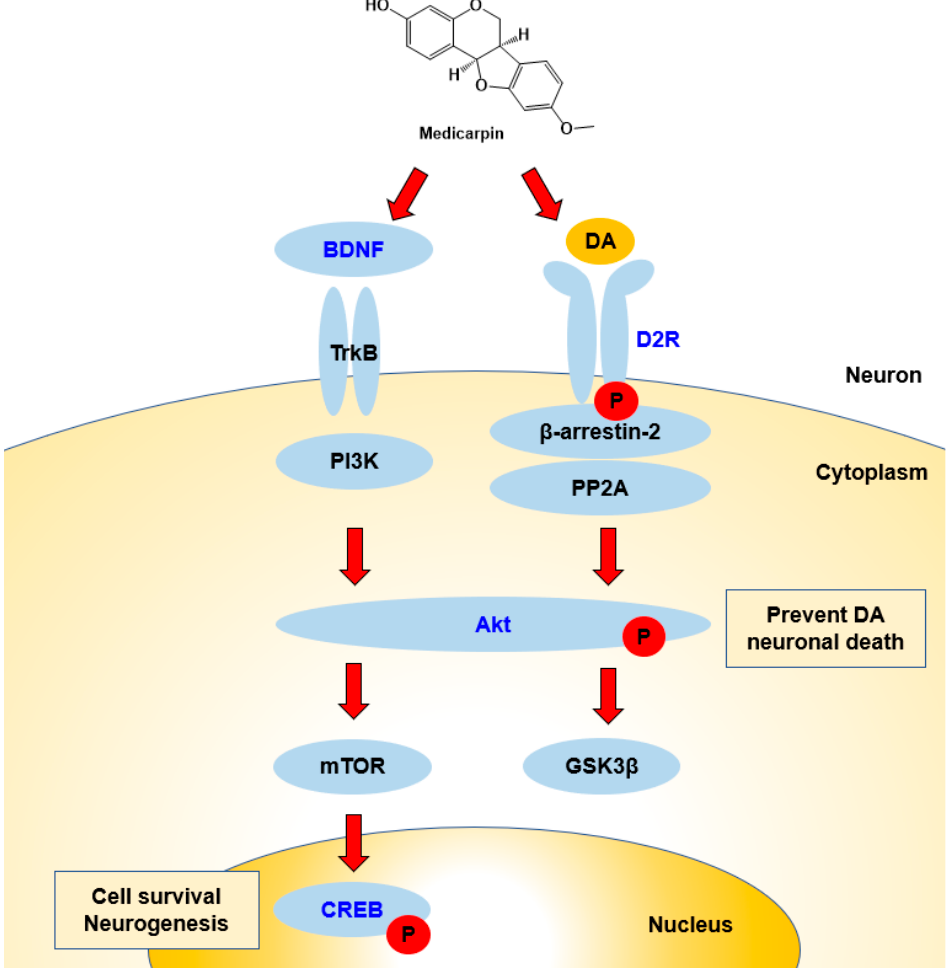
Figure 8. Possible responses of BDNF/Akt/CREB and D2R signaling pathways during interactions with MC. BDNF activates Akt, and next, Akt activates CREB, which is related to cell survival and neurogenesis. D2R activates the Akt–GSK3 pathway, and the activation of Akt prevents DA neuronal death. Names in blue color represent the factors tested in this